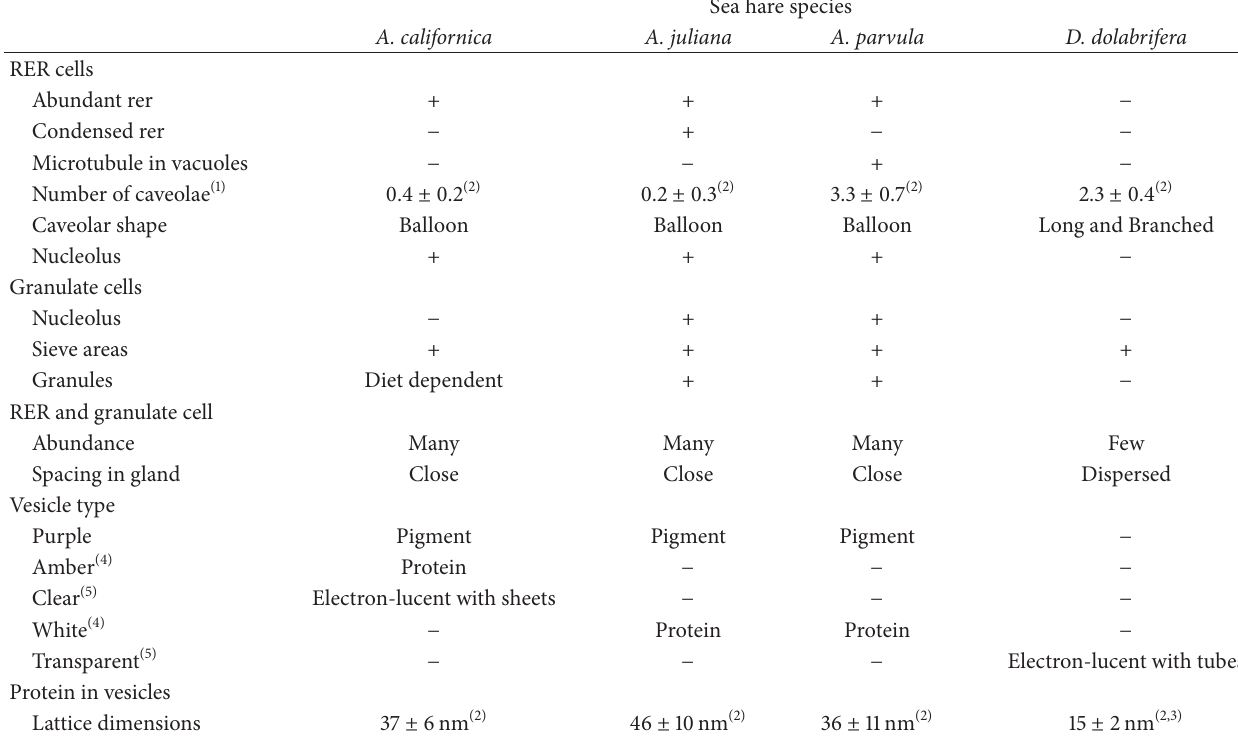
Table 1: Characteristics of the ink gland of four species of sea